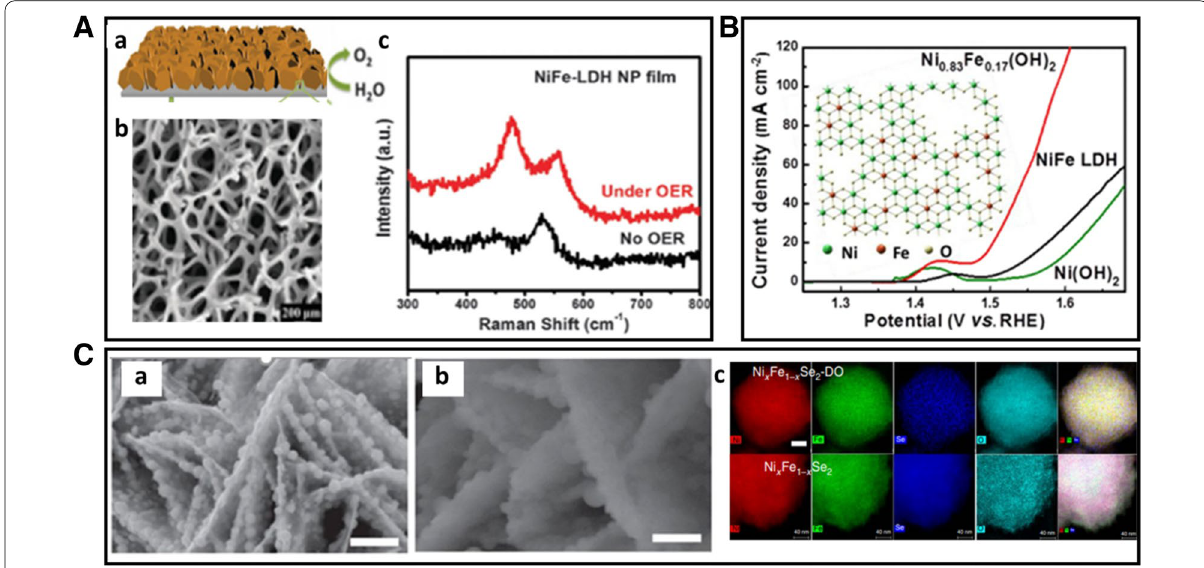
Fig. 15 A (a) Schematic illustration of NiFe‑LDH nanoplates grown on nickel foam, (b) SEM image of Ni foam, (c) in situ Raman spectra of NiFe‑LDH films with and without OER operation (Figure reprinted with permission from Ref. [65]). B iR‑corrected LSV polarization curves of Ni 0.83 Fe 0.17 (OH) 2 , NiFe LDH and Ni(OH) 2 (Figure reprinted with permission from Ref. [66]). C SEM images of (a) Ni x Fe 1 Ni x Fe 1 Se 2 and Ni x Fe 1 Se 2 ‑Do in elemental mapping images (Figure reprinted with permission from Ref. − x − x